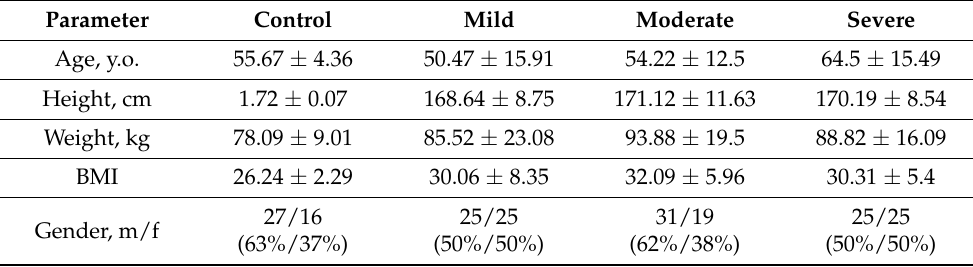
Table 5. Anthropometric variables of the studied groups. Parameter Control Mild Moderate Severe Age,